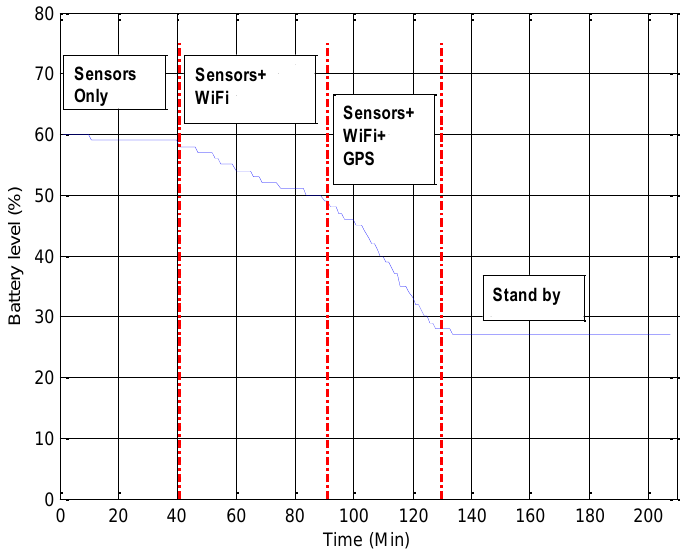
Figure 10. Battery drain on a